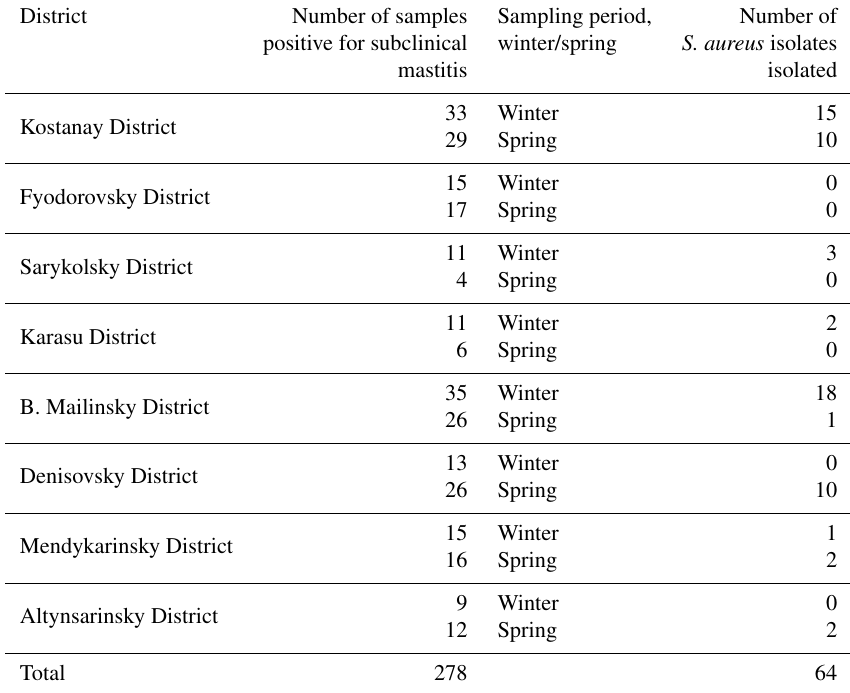
Table 2. The prevalence of subclinical mastitis in milk samples on farms in the Kostanay region.